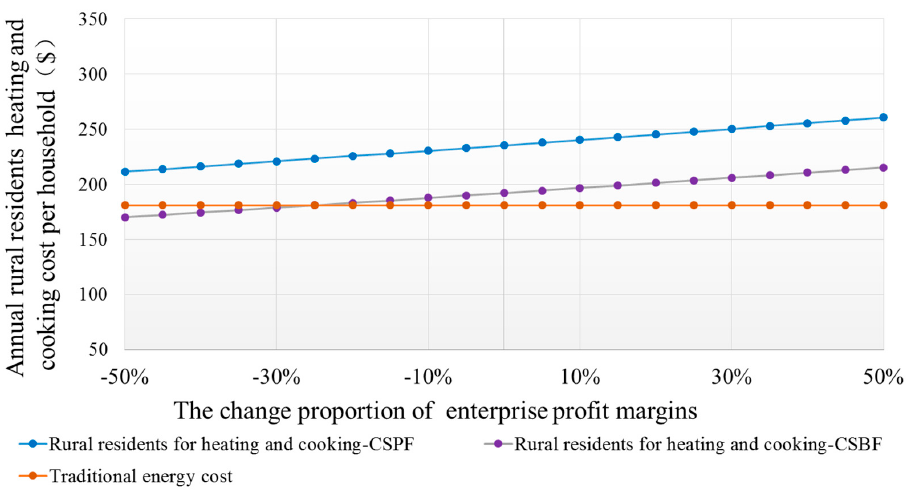
Figure 13. Influence of enterprise profit margin on the economic performance of CSDF for rural residents’ heating and cooking.